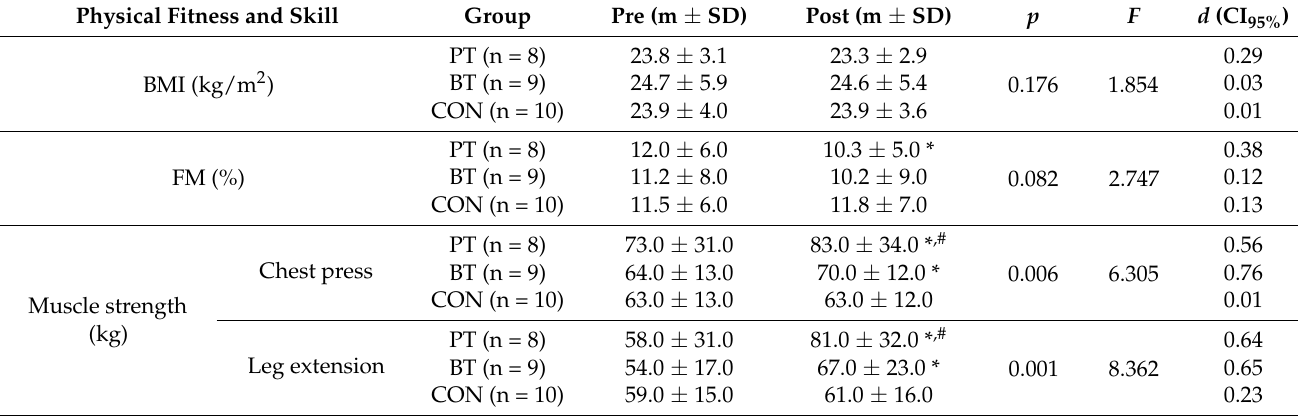
Table 3. Changes in BMI, FM%, and muscle strength after the 8-week intervention.